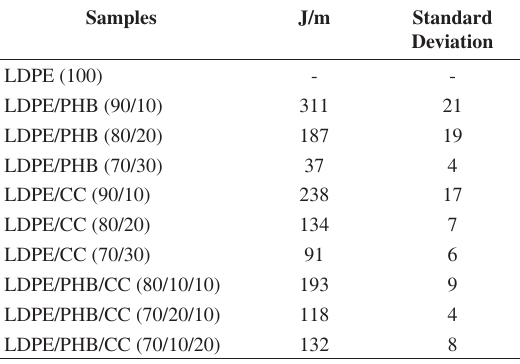
Figure 4. Response surface plot of elongation at break. Table 3. Impact resistance values of LDPE and LDPE/PHB/CC mixtures.